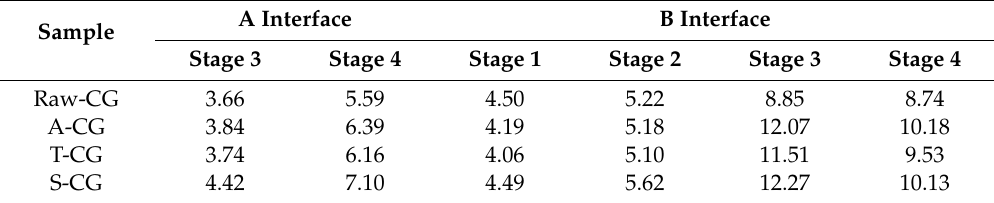
Table 4. Maximum shear stress at di ff erent stages / kN · m − 2 .